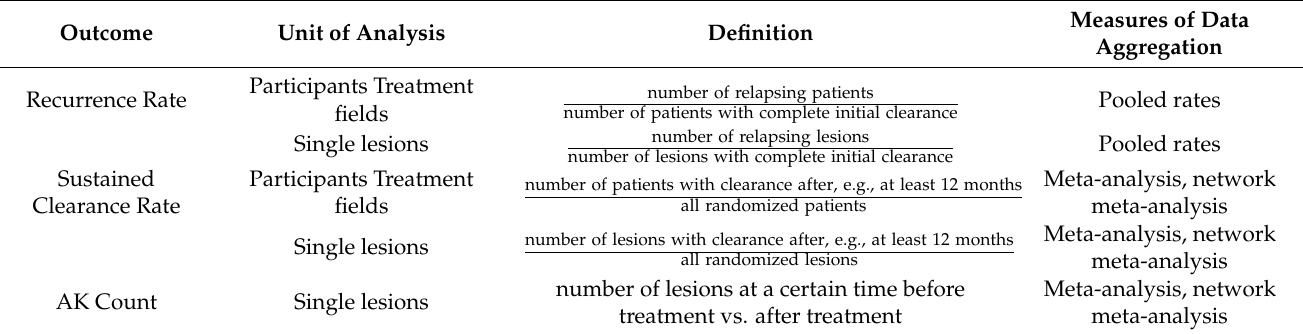
Table 1. Definitions of the long-term efficacy outcomes for